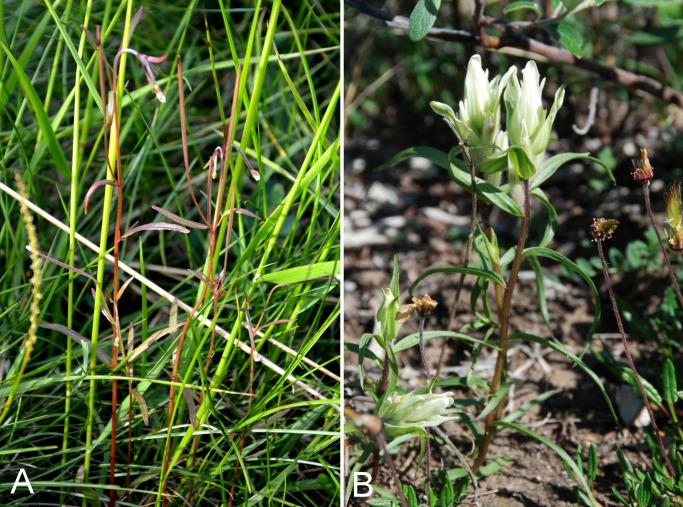
Epilobium palustre and Castilleja caudata.Epilobium palustre: (A) habit, Saarela et al. 4103. Castilleja caudata: (B) habitat, Saarela et al. 3183. Photographs by P. C. Sokoloff (A) and J. M. Saarela (B).